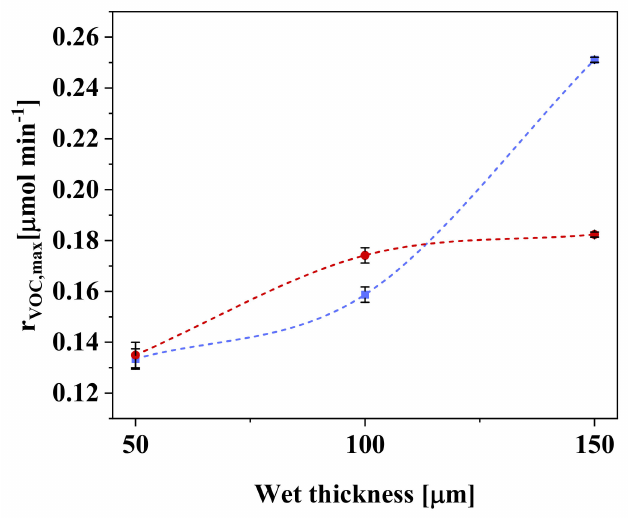
Figure 8. Maximum conversion rate of n -decane ( r VOC,max ) as a function of photocatalyst mass, with ( (cid:4) ) and without ( • ) use of pore-forming agent. Conditions: irradiation intensity = 245.5 W m − 2 ; C VOC,feed = 78.8 ppm; Q feed = 150 cm 3 min − 1